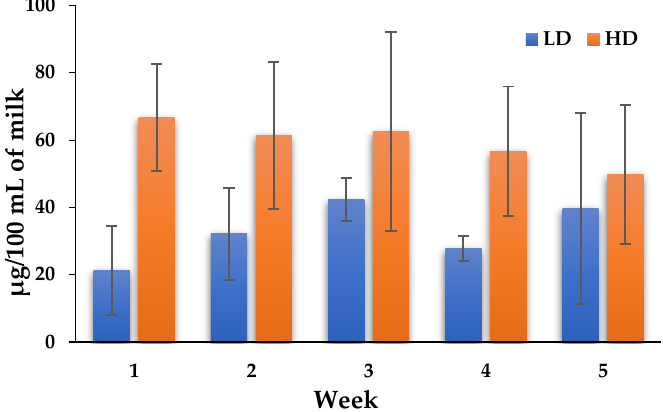
Figure 1. Milk caffeine mean concentrations (SD over four samples are shown as error bars) across the five weeks of experimentation. Within LD and HD groups, week means were not statistically different at p < 0.001. Caffeine levels were not detectable in the control